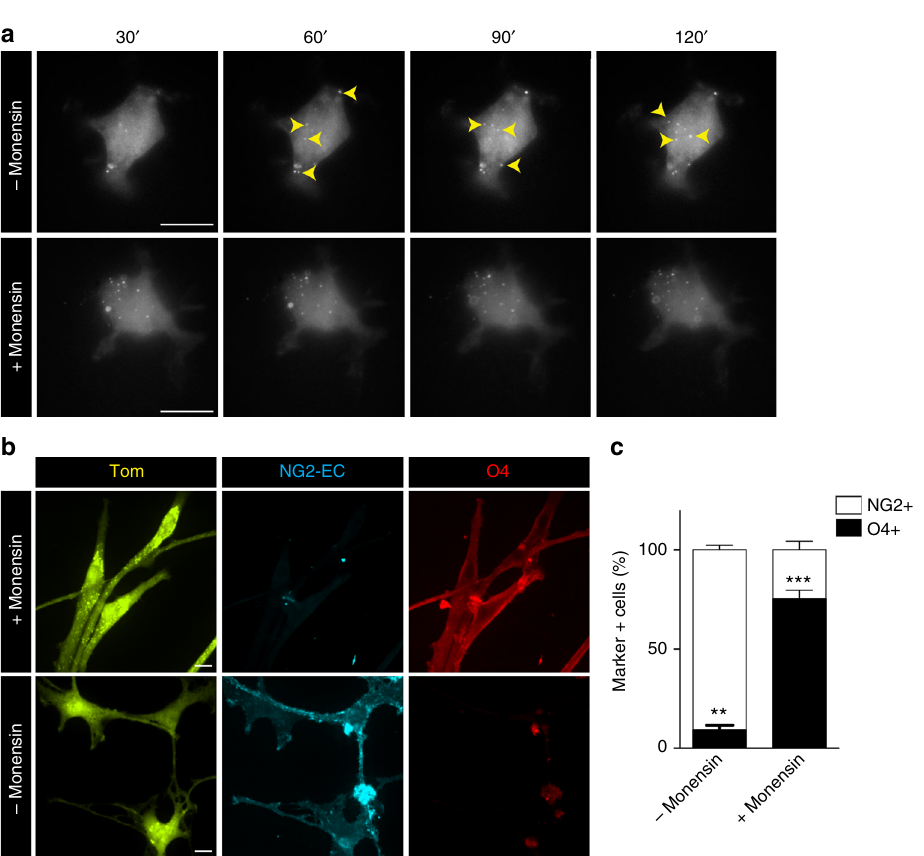
Fig. 8 Aberrant NG2 recycling is linked to differentiation defects. a Steady-state images of two single Lgl1 cKO cells monitored for NG2-EC (white dots) by TIRF, treated (bottom panel) or not treated (upper panel) with monensin. Pictures are acquired each 30 seconds. Note that NG2 is recycled to the membrane in non-treated cells (yellow arrow), whereas no recycling is observed in treated cells. Scale bar: 10 μ m. b Fluorescent pictures illustrating Lgl1 cKO cells (Tom) monensin -treated or untreated and labeled for NG2 (blue) and O4 (red) after 5 days in differentiation conditions. Scale bar: 10 μ m. c Graph representing quanti fi cation of O4 + and NG2 + cells in monensin-treated or untreated Lgl1 cKO cells. Untreated cells are mostly NG2 + and O4 − , whereas treated cells show a reverse phenotype with a higher number of cells expressing O4. Data are depicted as mean ± s.e.m., n = 20 cells per genotype, three independent experiments (** p < 0.01, Student's t